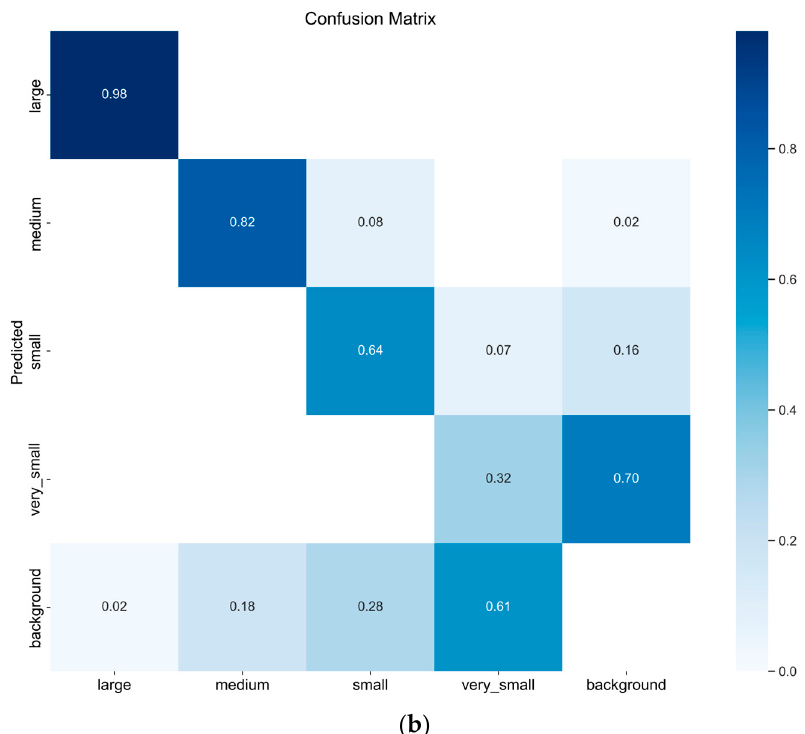
Figure 9. Confusion matrix of DET-YOLO on the DOTA dataset at an IoU threshold of 0.45 and a confidence threshold of 0.25: ( a ) Confusion matrix based on the class of the target; ( b ) Confusion matrix based on the size of the target.